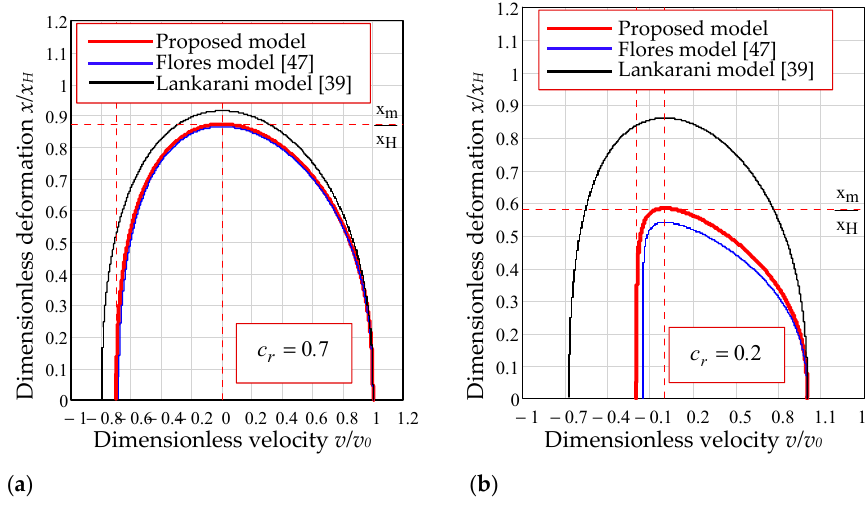
Figure 19. Impact force versus time for the three models: ( a ) c r = 0.7 and ( b ) c r = 0.2.